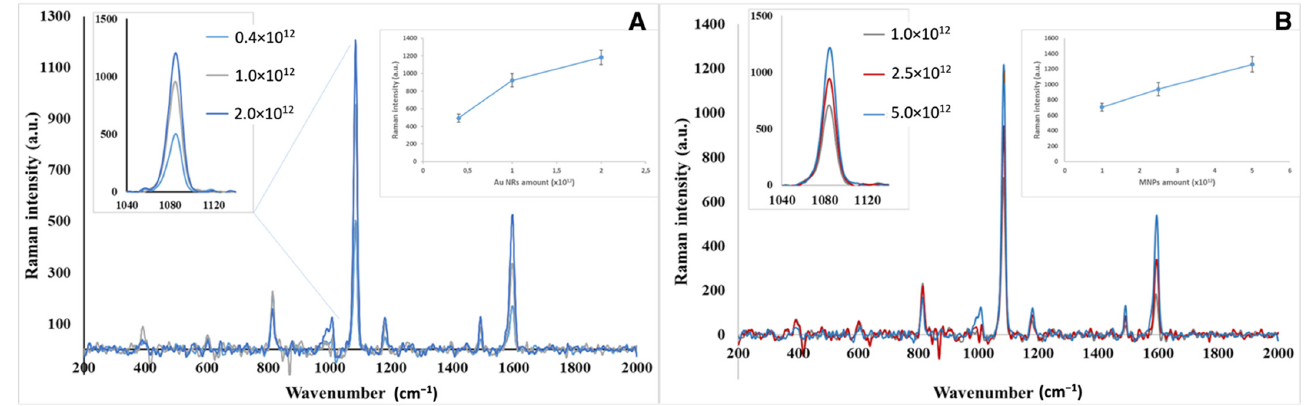
Figure 4. ( A ) SERS spectra obtained for Au NR amount optimization; ( B ) SERS spectra obtained for MNP amount optimization.